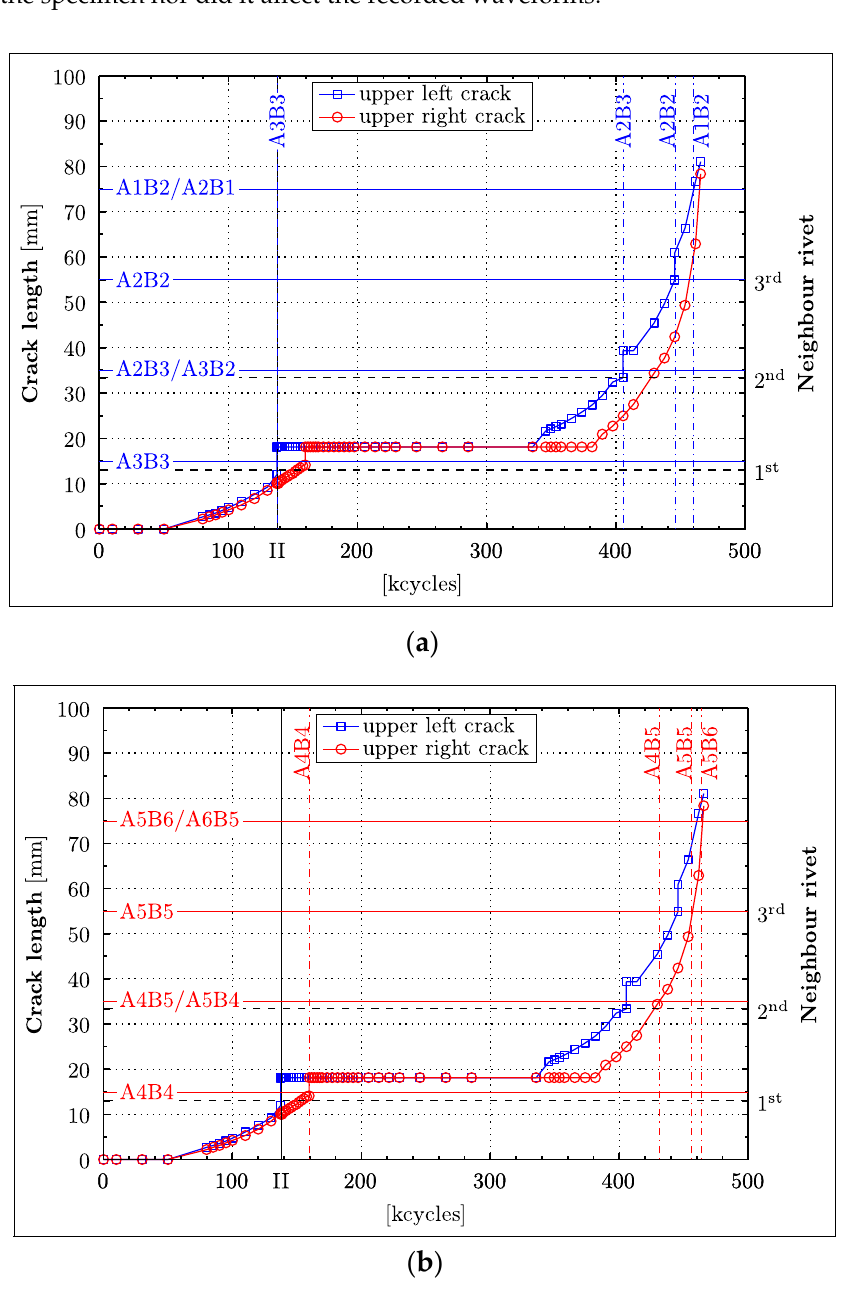
Figure 3. Crack propagation curves. The thin vertical solid line (described by the symbol “II”) separates the two experimental tests (PHASE 1 and PHASE 2) investigated. The other lines indicate at which point in time (or after how many fatigue cycles) the cracks intersected the respective wave propagation paths. These other lines are plotted for: ( a ) LEFT wave propagation paths; ( b ) RIGHT wave propagation paths.